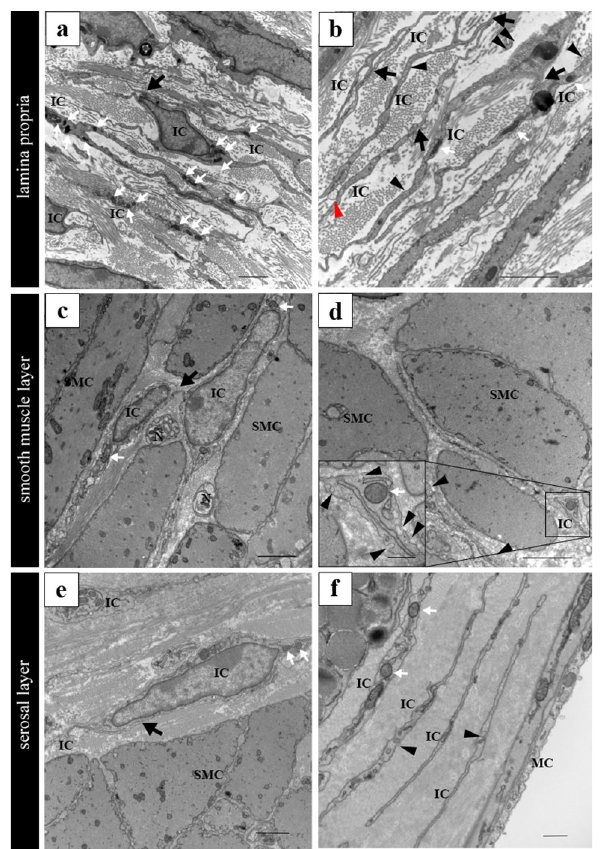
Figure 6. ( a ) ICs in the lamina propria of the vas deferens. ( b ) Cell processes of ICs in the lamina propria. Exosome-like structure between cell processes of ICs (red arrowhead). ( c ) ICs in the smooth muscle layer of the vas deferens. ( d ) Cell processes of ICs in the smooth muscle layer. High magnification of the solid black line square area (inset at the lower left corner of ( d )). ( e ) ICs in the serosal layer of the vas deferens. ( f ) Cell processes of ICs in the serosal layer. ICs’ cell bodies are relatively small, with sparse cytoplasm containing several mitochondria surrounding the nucleus (white arrows). ICs were in close proximity to each other (black arrows). Caveolae in the cytoplasm of ICs in all the layers (black arrowheads). IC, interstitial cells; SMC, smooth muscle cells; E, epithelium; MC, mesothelial cells. Scale bars: 2 μm ( a – e ); 500 nm ( f , inset at the lower left corner of ( d